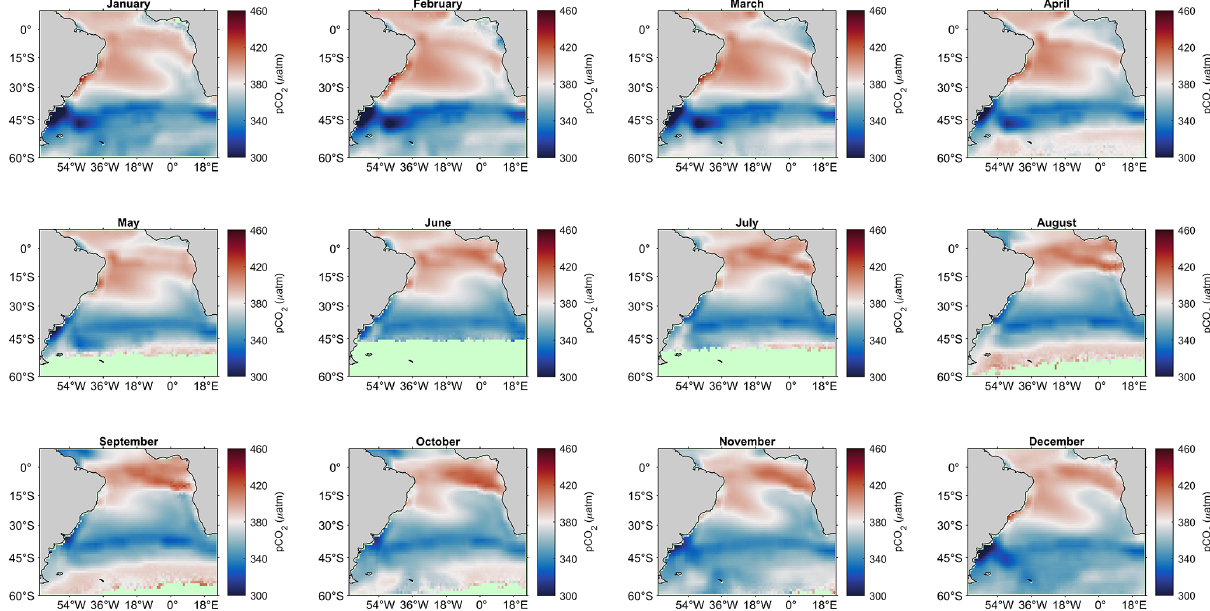
Figure B1. Monthly climatologies of p CO 2 ( sw ) between July 2002 and December 2018 estimated by the SA-FNN NCP approach referenced to 2010. The atmospheric CO 2 increase was set as 1.5µatmyr − 1 . The colour scale is centred on the atmospheric concentration for 2010 ( ∼ 380µatm). Red shaded areas indicate oversaturated regions, and blue shaded areas indicate undersaturated regions. Light green areas indicate where no input data to compute p CO 2 ( sw ) are available.